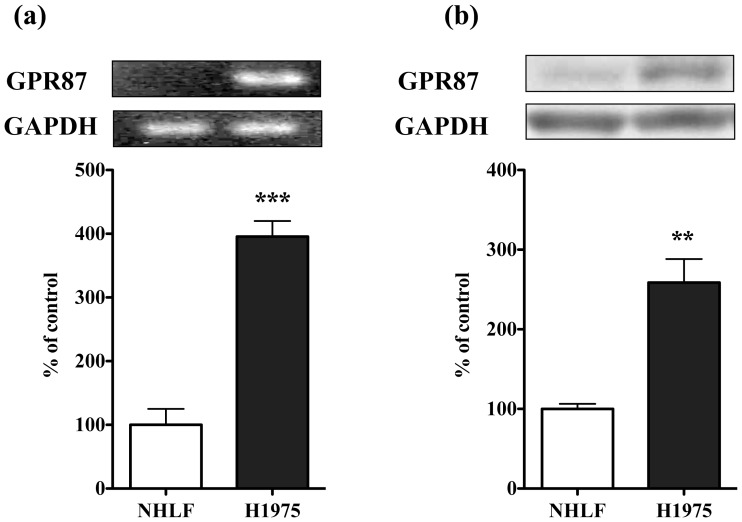
Expression ratio of Gα subunit (Gs, Gi and Gq) in H1975 cells.The percentage of expression pattern of Gα subunit (Gs: red, Gi: blue and Gq: green) in the up- or down-regulated GPCRs of H1975 cells compared to NHLF is shown.